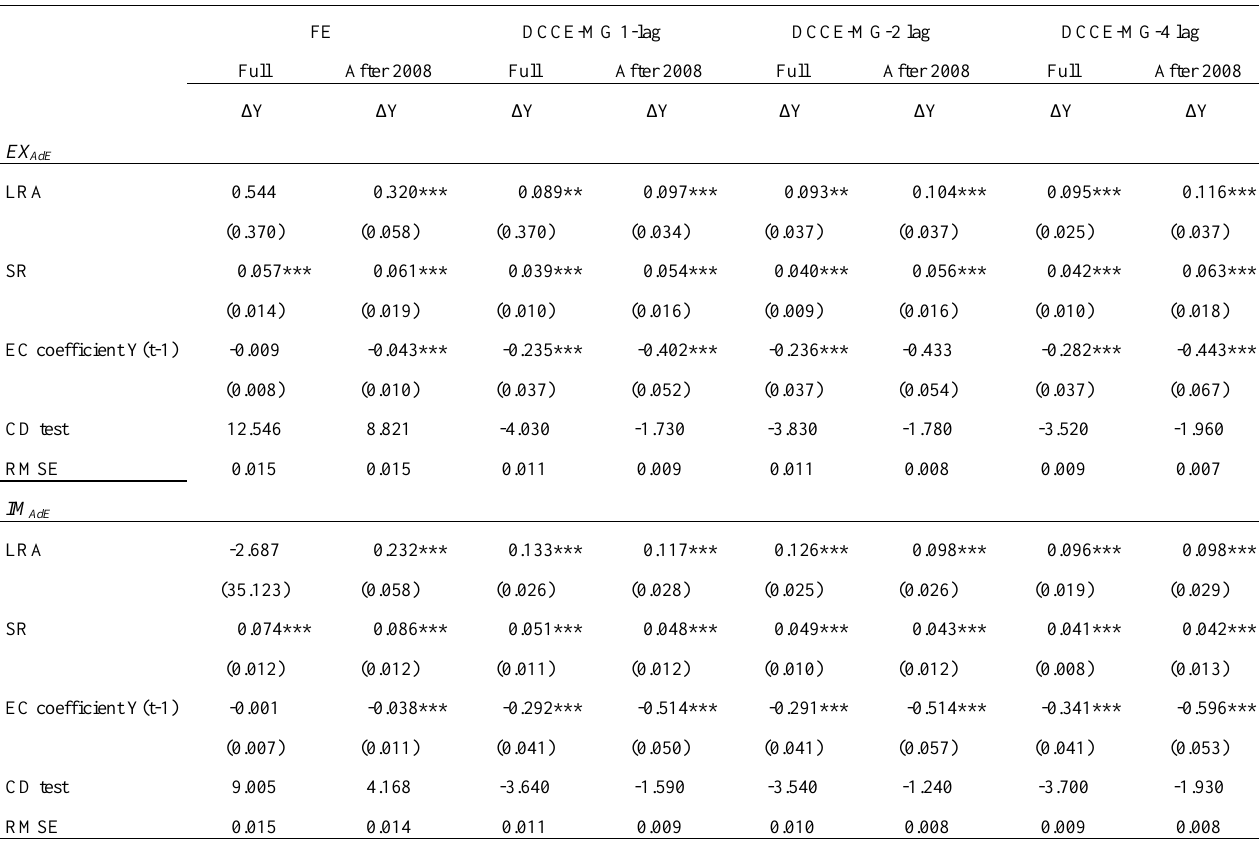
Table 7c : Dynamic models with the independent variables export and import to advanced economies FE DCCE-MG 1-lag DCCE-MG-2